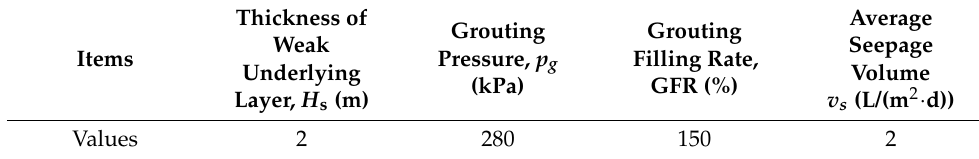
Table 5. Parameters for simulating.